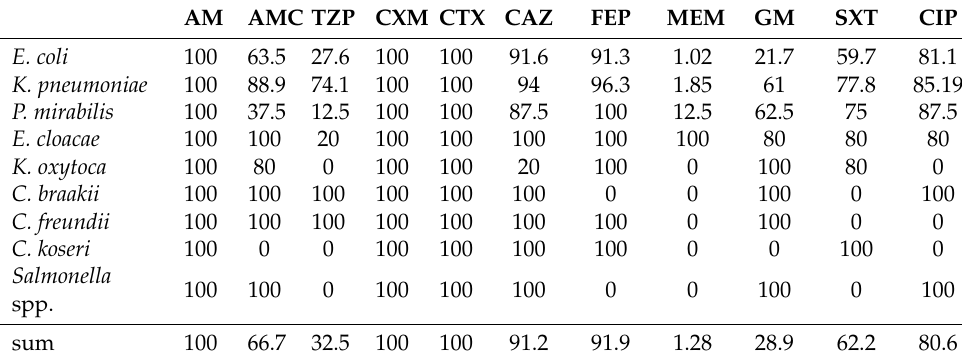
AM: ampicillin; AMC: amoxicillin/clavulanic acid; TZP: piperacillin/tazobactam; CXM: cefuroxime; CTX: cefotaxime; CAZ: ceftazidime; FEP: cefepime; MEM: meropenem; GM: gentamicin; SXT: trimetho-